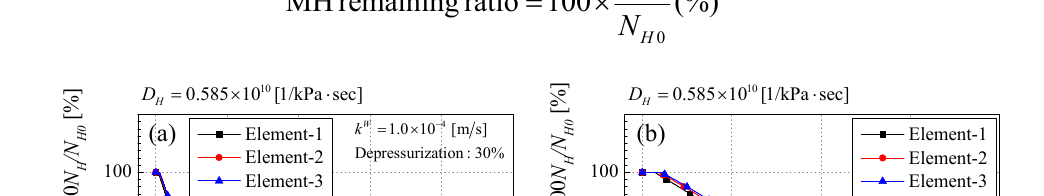
Figure 9. Time profiles of the remaining MH ratio ( b ) Case-4-40; ( c ) Case-7-30; ( d )